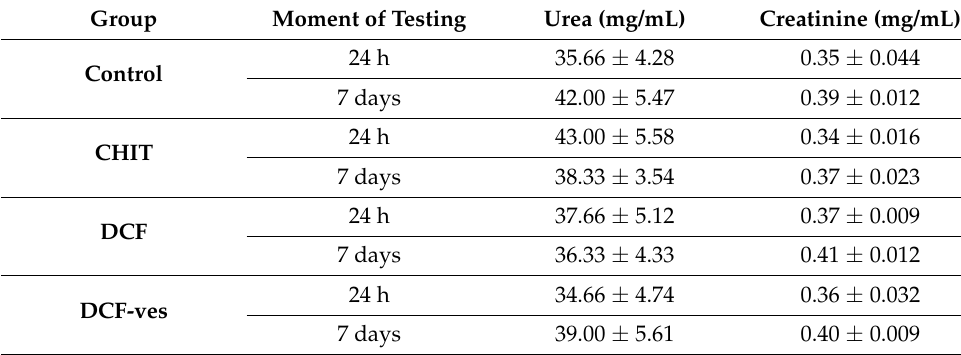
Table 6. Serum urea and creatinine levels in animals treated with CHIT, DCF and DCF-ves. Values are expressed as the arithmetic mean ± S.D. of the average values for 6 animals per group. Group Moment of Testing